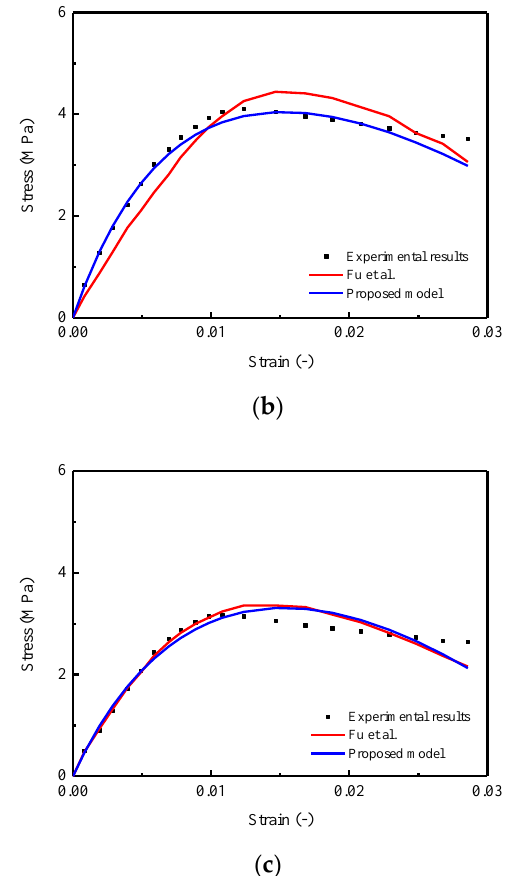
Figure 13. Comparison between experimental (Fu et al., 2014) and theoretical curves: ( a ) Strain rate at 0.0033/𝑚𝑠 −1 ; ( b ) Strain rate at 0.17/𝑚𝑠 −1 ; ( c ) Strain rate at 1.7/𝑚𝑠 −1 .